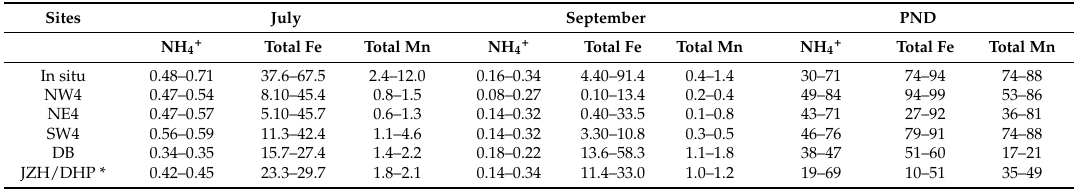
Table 1. Concentrations of NH 4+ (mg/L), total Fe and total Mn ( μ g/L) at the sampling sites and the percentage net decrease of NH 4+ , total Fe and total Mn (PND, %) for the corresponding sites from July